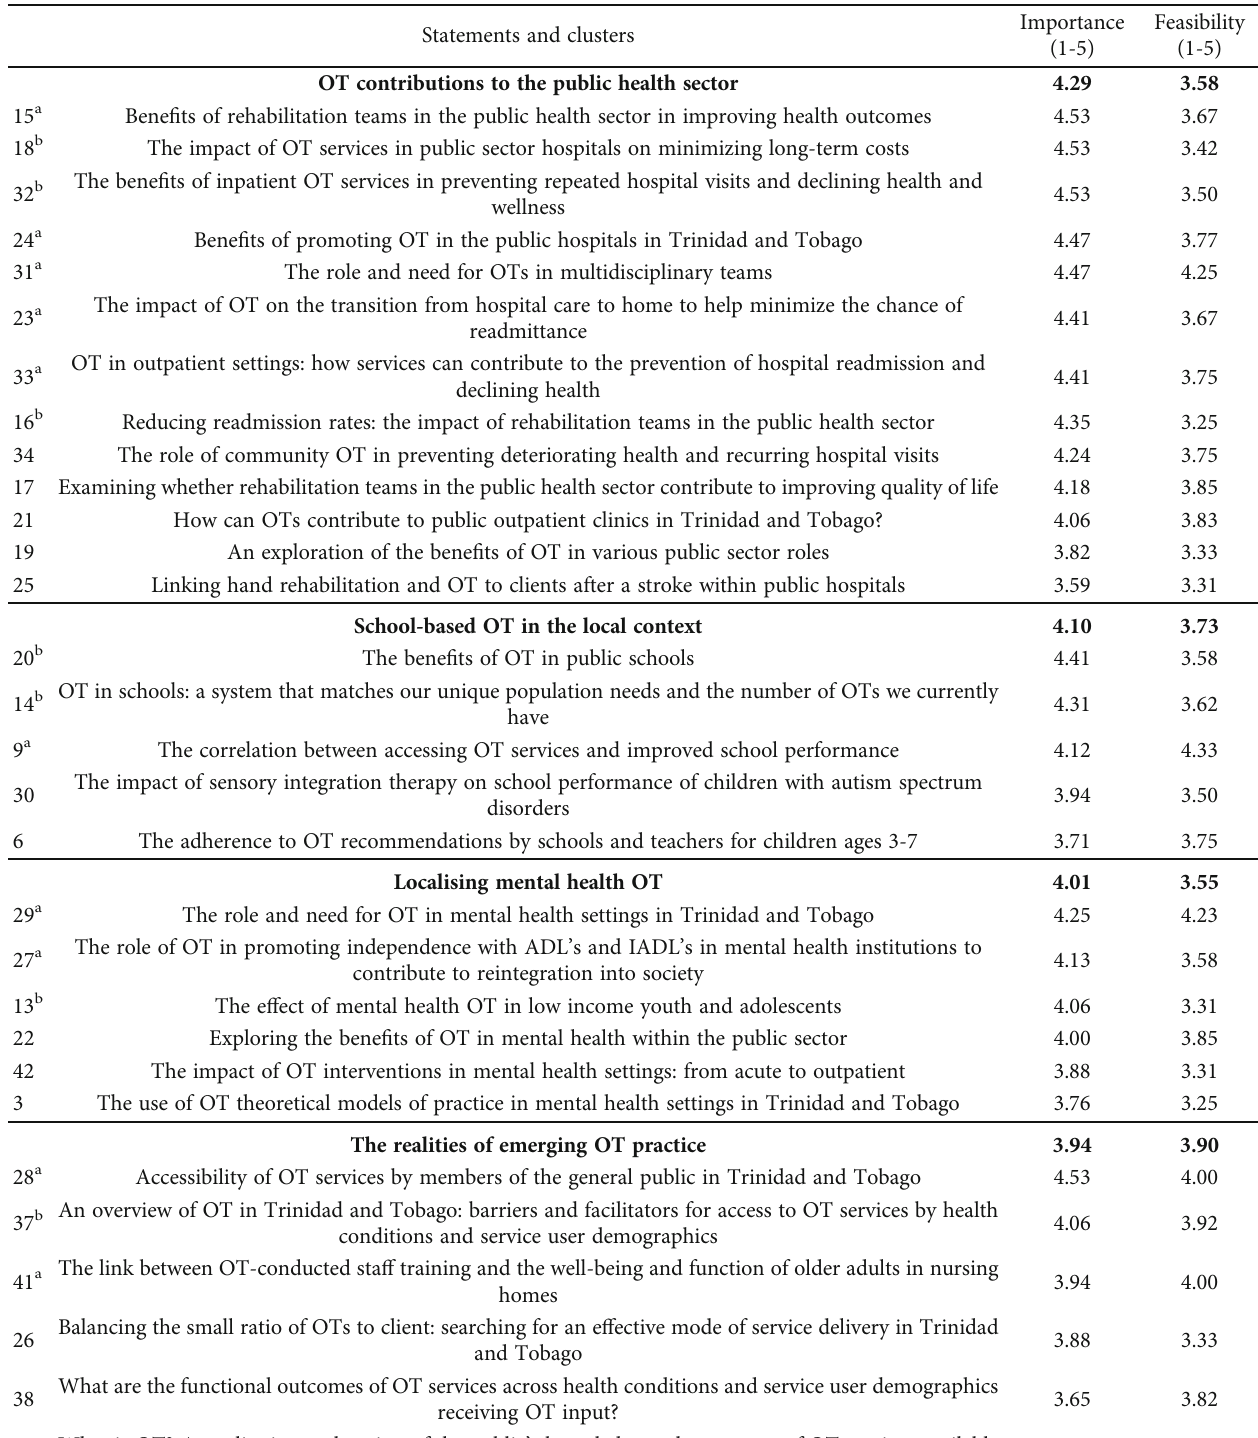
Table 1: Mean importance and feasibility rating scores for clusters and